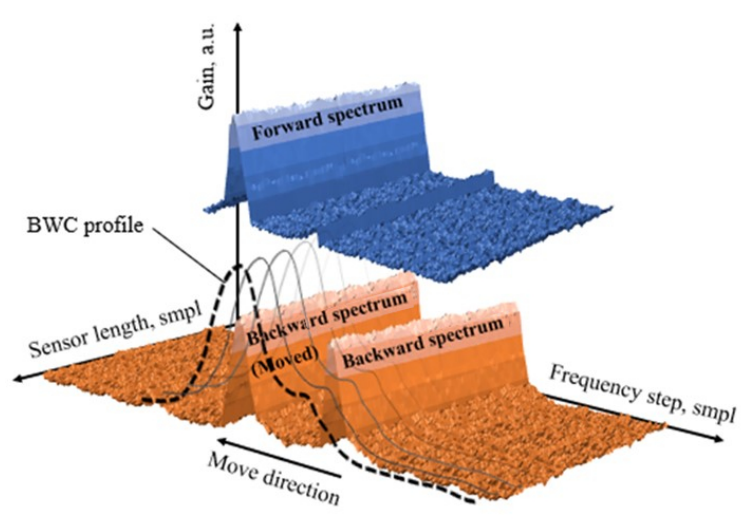
Figure 2. A schematic diagram combined using real data, describing the method operation principle (blue graph—forward spectrum; orange graph—backward spectrum with its shifted copy; dotted line—backward correlation